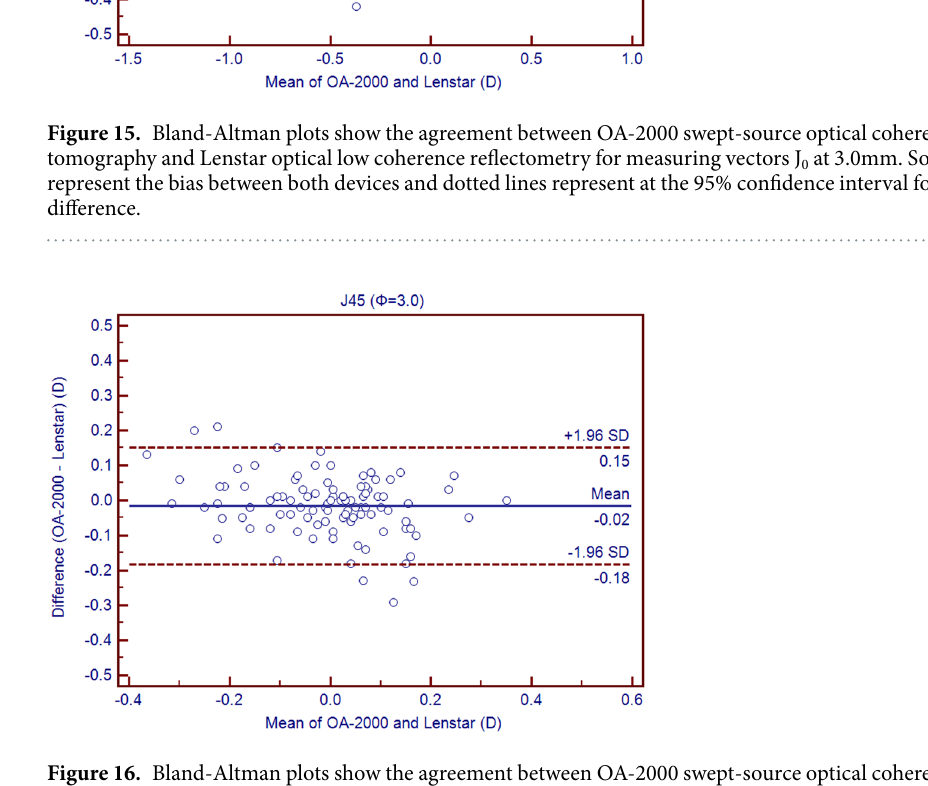
Figure 16. Bland-Altman plots show the agreement between OA-2000 swept-source optical coherence tomography and Lenstar optical low coherence reflectometry for measuring vectors J 45 at 3.0 mm. Solid lines represent the bias between both devices and dotted lines represent at the 95% confidence interval for the difference.